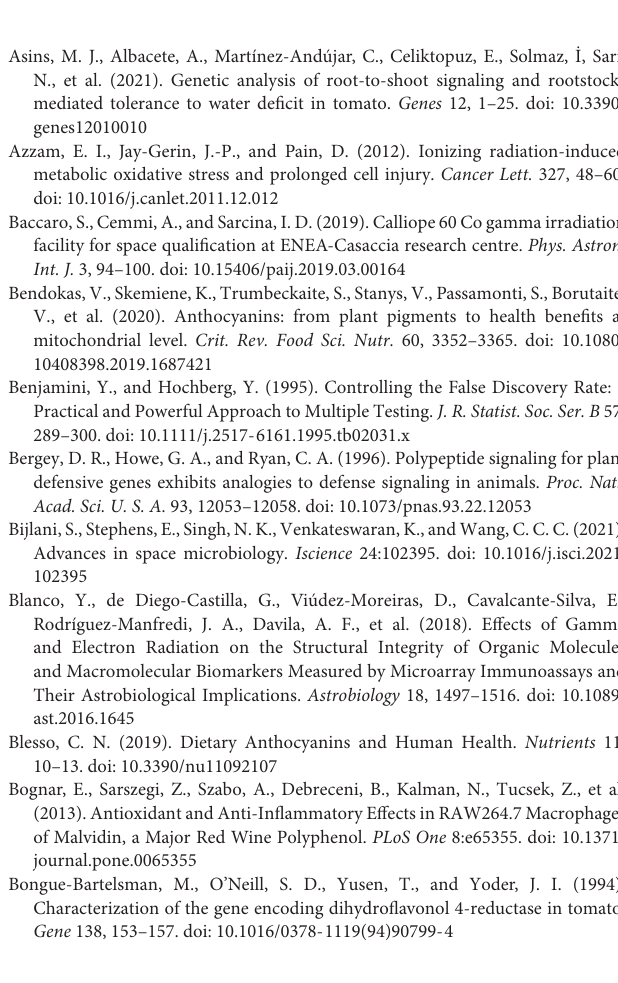
Supplementary File 2 | List of figures representing the level of different flavonoids in control and PhAN4 HRCs. Supplementary File 3 | Complete list of DEGs. Supplementary File 4 | GOE analysis